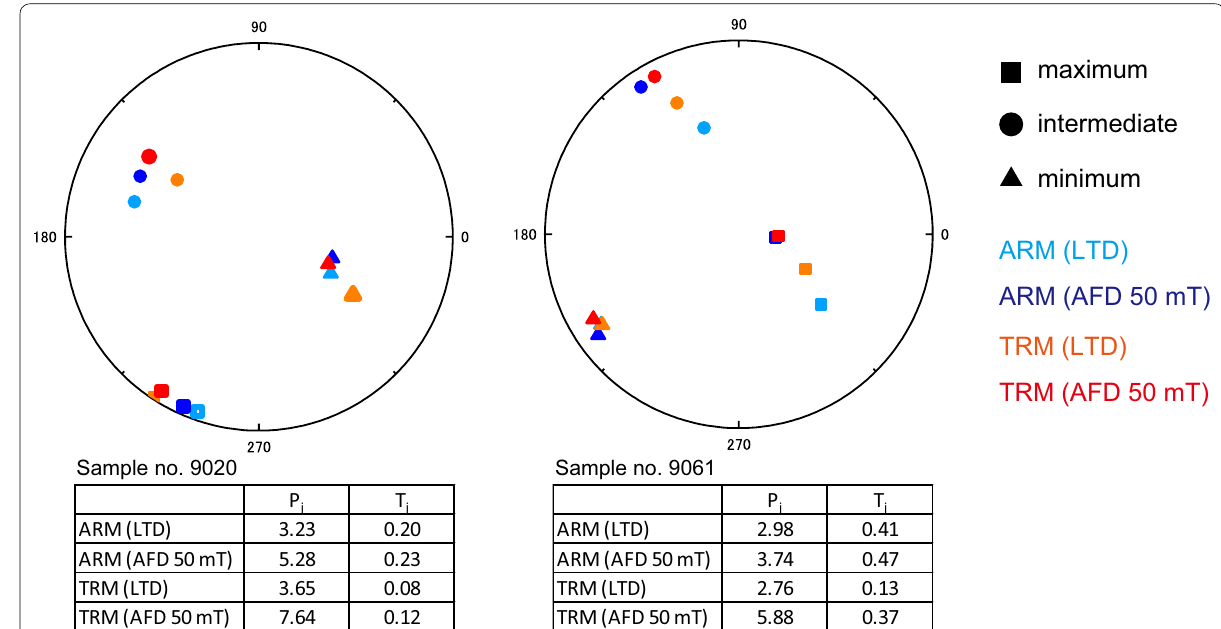
Fig. 12 Representative results on the anisotropy axes measurement on single plagioclase crystals. Sample holder coordinate (not oriented). Left side, sample with prolate anisotropy; right side, sample with oblate